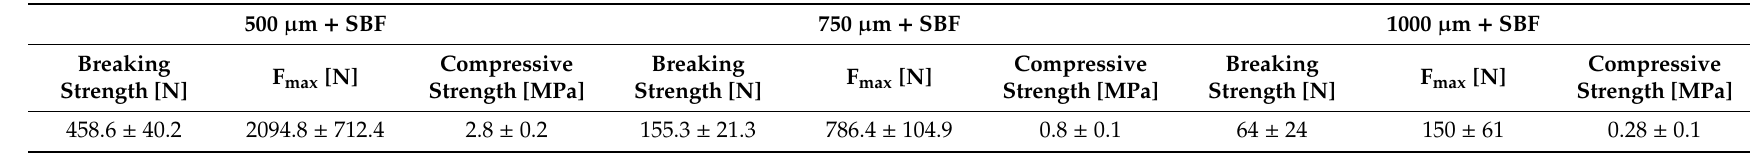
Table 5. Breaking and compressive strength of the di ff erent SBF-treated samples (N = 10)